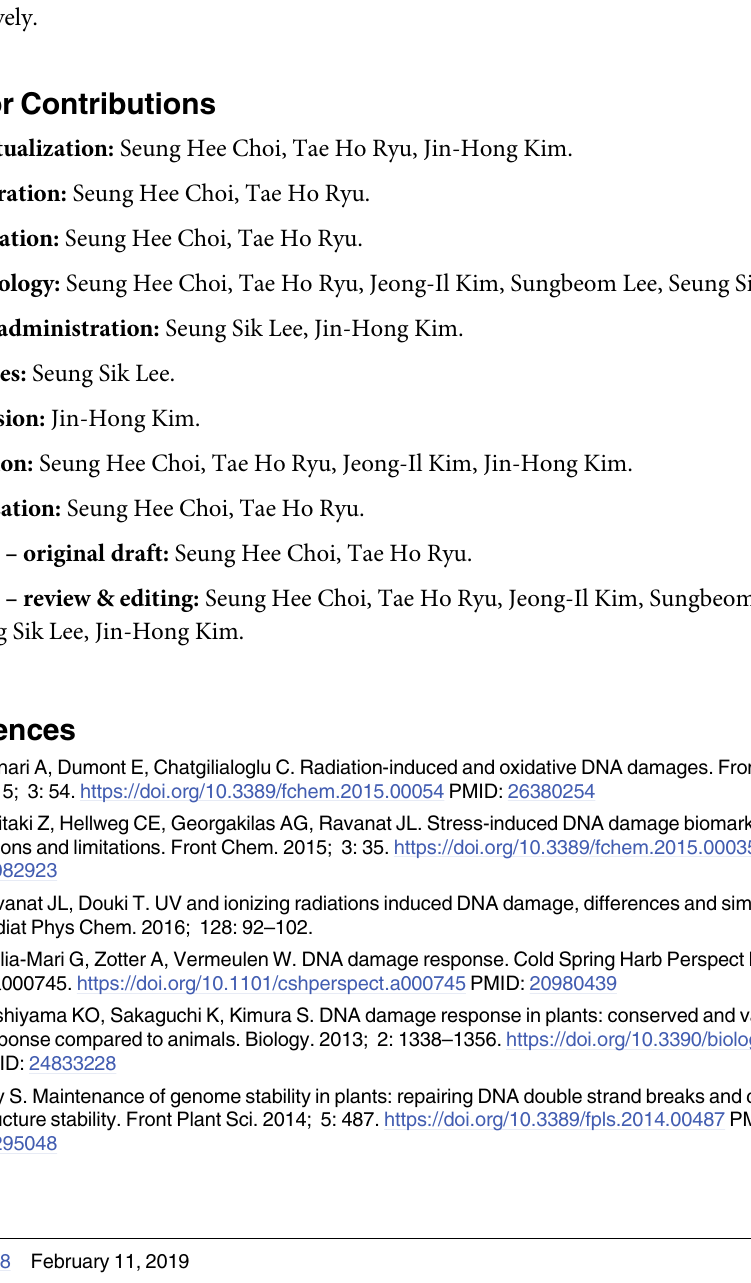
S1 Table. Oligonucleotide primers used for qRT-PCR. (DOCX) S1 File. List of differentially expressed genes (DEGs) with more than 2-fold difference by comparison of gene expression levels between 200 Gy-treated WT and 200 Gy-treated ddm1-2